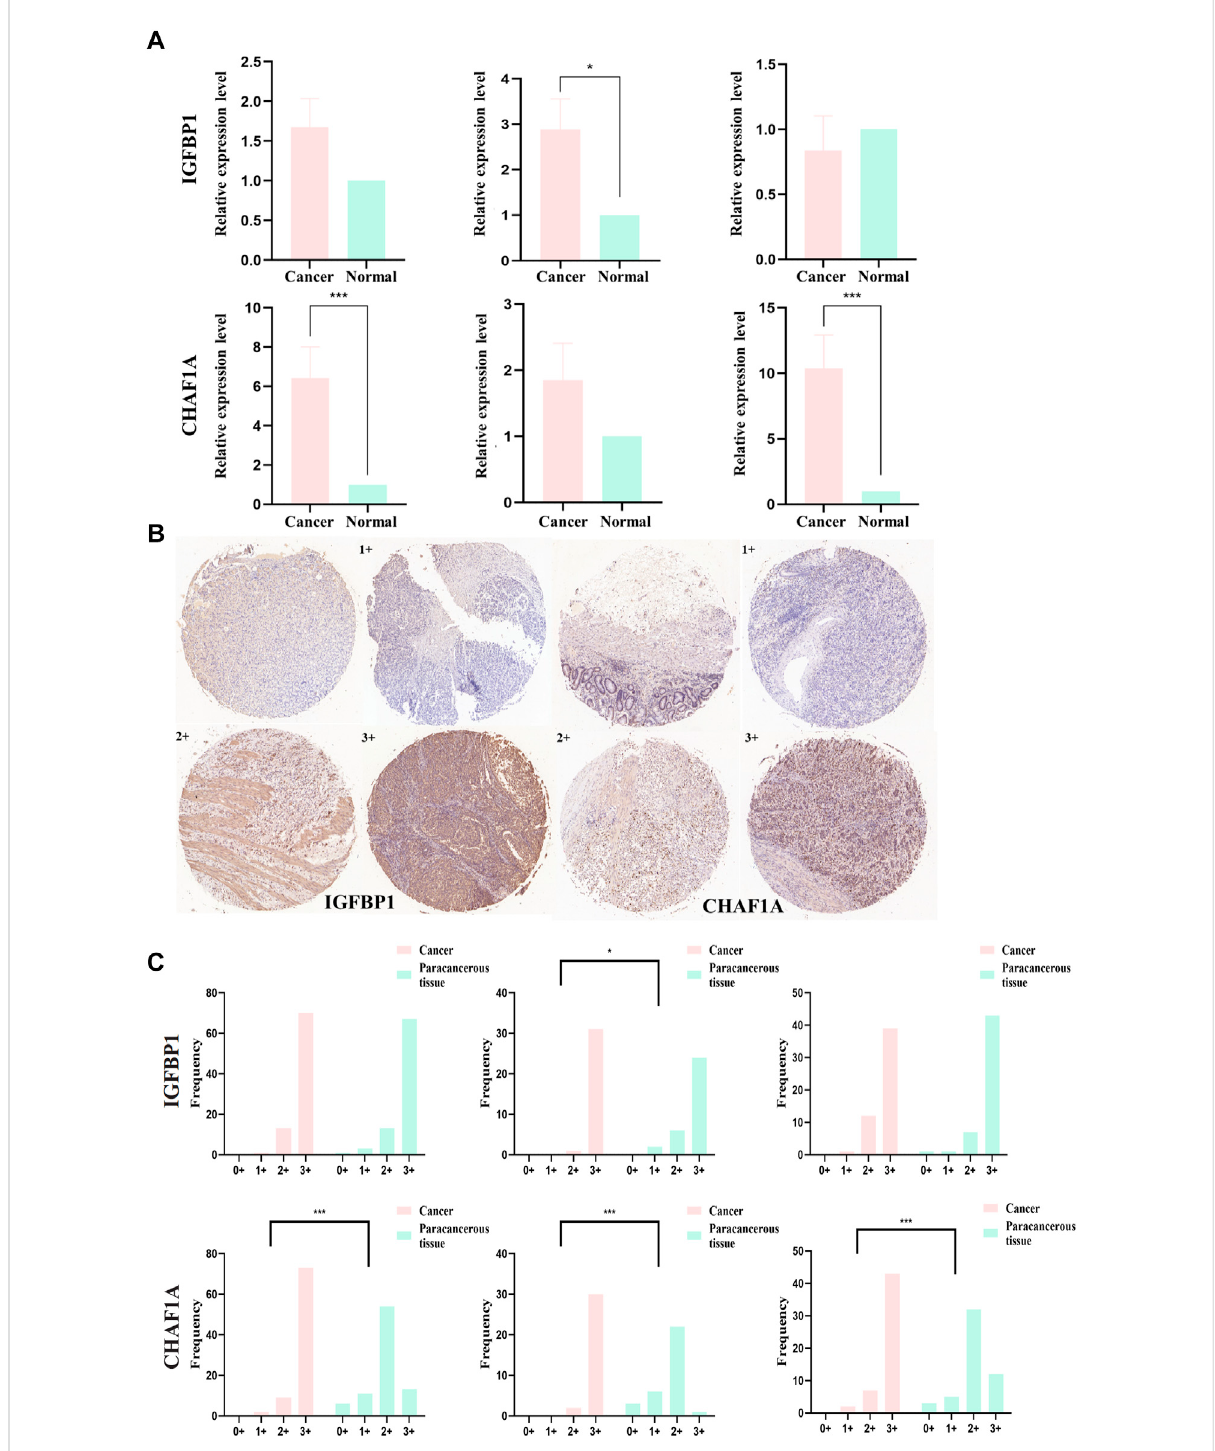
FIGURE 9 mRNAandproteinexpressionlevelsofIGFBP1andCHAF1AevaluatedfromSTADandnormalsamplesbyqPCRandIHC,respectively. (A) MRNAexpression levels of IGFBP1 and CHAF1A detected by qPCR in 30 STAD and paired paracancerous normal tissues (early-stage: 13 pairs and progressive-stage: 17 pairs). (B) RepresentativeimagesofIHCdisplayingnegative(0),low(1+),moderate(2+),andstrong(3+)stainingforIGFBP1andCHAF1Aproteinsfrom84STADandpaired paraneoplasticnormaltissues(early-stage:32pairsandprogressive-stage:52pairs).Variousstainingintensitiesofmatchedcancerandnormaltissueswere demonstrated,respectively,forIGFBP1andCHAF1A. (C) IHCscoresofoverall,early-stage,andprogressive-stageSTAD,andpairednormaltissuesarepresentedin histograms with frequency. The statistical analysis was performed using Pearson ’ s χ 2 test and likelihood ratio test. * p < 0.05 and *** p <